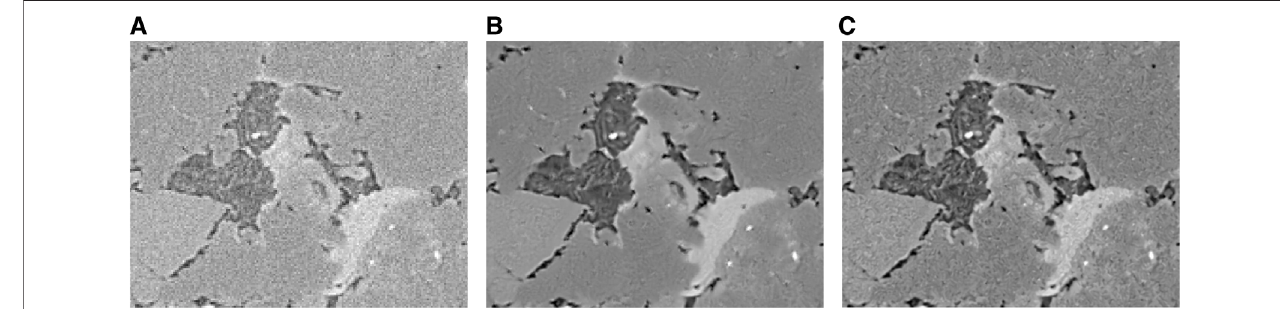
Frontiers in Physics |